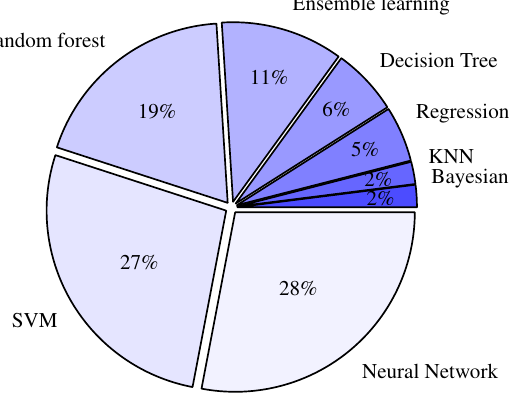
Figure 6. Distribution of the use of ML algorithms for eHealth applications, based on data from